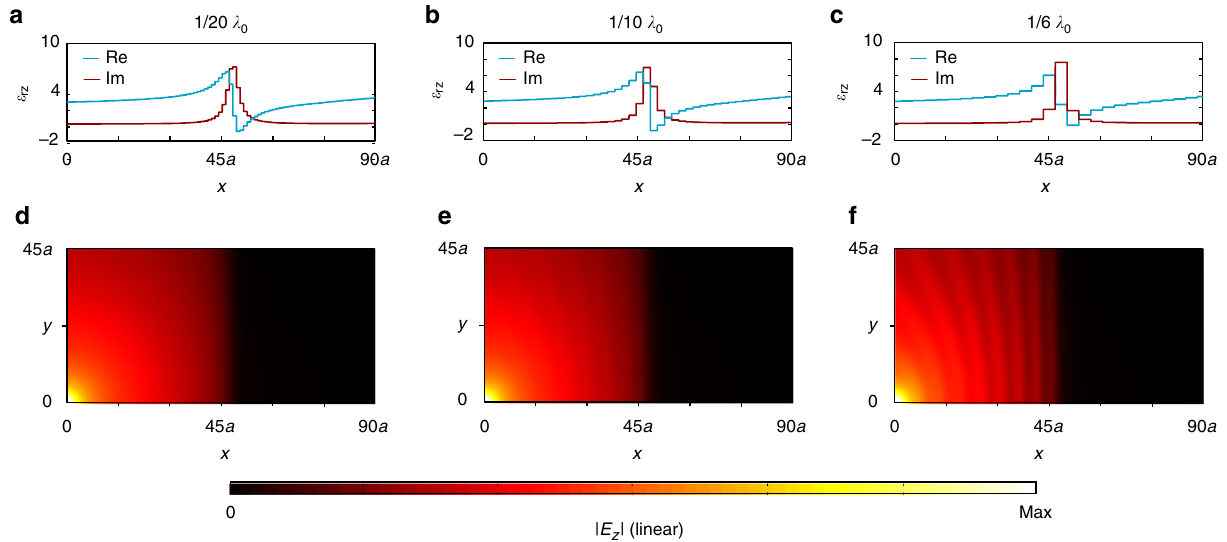
Fig. 7 Performances of discrete spatial Kramers – Kronig pro fi les with different discretization steps analyzed at 2.4 GHz. a – c The discrete x -dependent Kramers – Kronig pro fi le with discretization steps of λ 0 /20, λ 0 /10, and λ 0 /6, respectively. d – f The corresponding simulated amplitudes of the electric fi elds. The units of the x and y axis are the width a of the unit cell, as shown in Fig. 3a. Note that the same absolute color scale is used in these fi gures